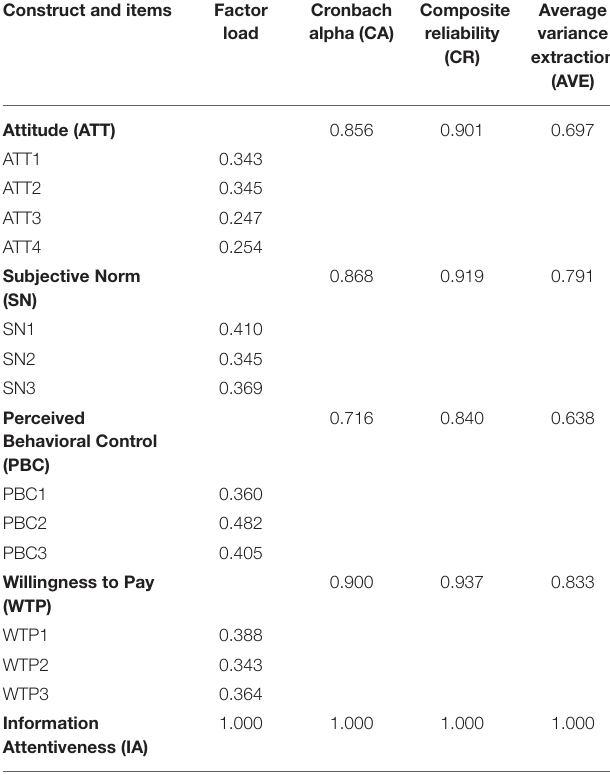
TABLE 4 | Reliability and validity